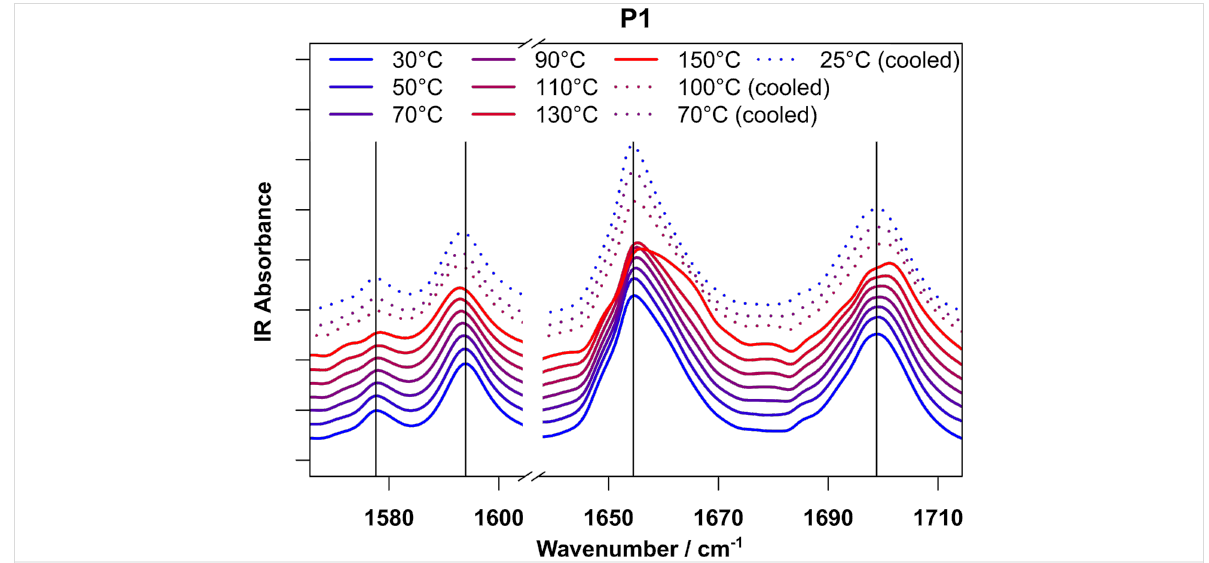
Figure 4: Temperature dependent IR spectra of P1 drop casted on KBr in the C=C (1570–1605 cm − 1 ) and C=O stretching region (1640–1710 cm − 1 ). During heating, slight shifts in the position of all bands (1578 cm − 1 : +1 cm − 1 ; 1594: − 1.5 cm − 1 ; 1656 cm -1 : +0.8 cm − 1 ; 1698: +1.5 cm − 1 . These shifts are partially reversed while cooling the polymer, indicating a reversible cause for the shifts. Additionally, all bands exhibit broadening during heating, especially noticeable at 150 °C, indicating a broader distribution of species contributing to the IR spectrum.